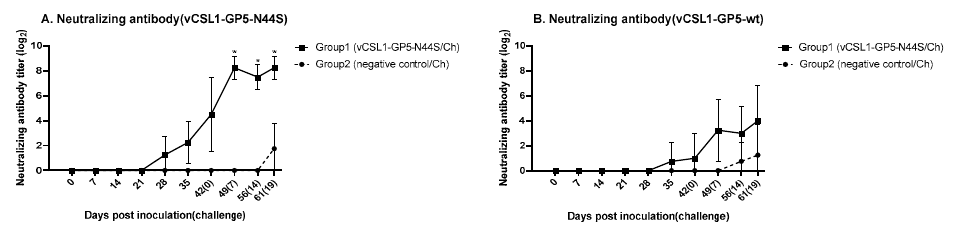
Figure 4. Changes in serum neutralizing antibodies after inoculation or challenge. Serum obtained 0, 7, 14, 21, 28, 35, and 42 d post-inoculation and 7, 14, and 19 d post-challenge was measured by a serum neutralization test against vCSL1-GP5-N44S ( A ) or vCSL1-GP5-wt ( B ). The symbol “*” indicates statistically significant differences from the negative control (* p ≤ 0.05).